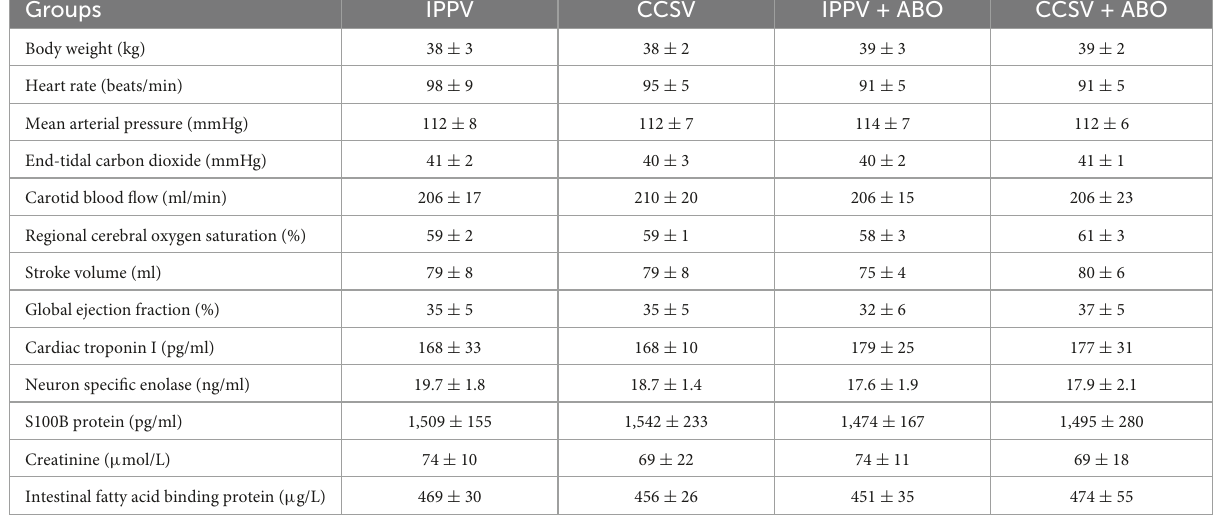
TABLE 1 Baseline